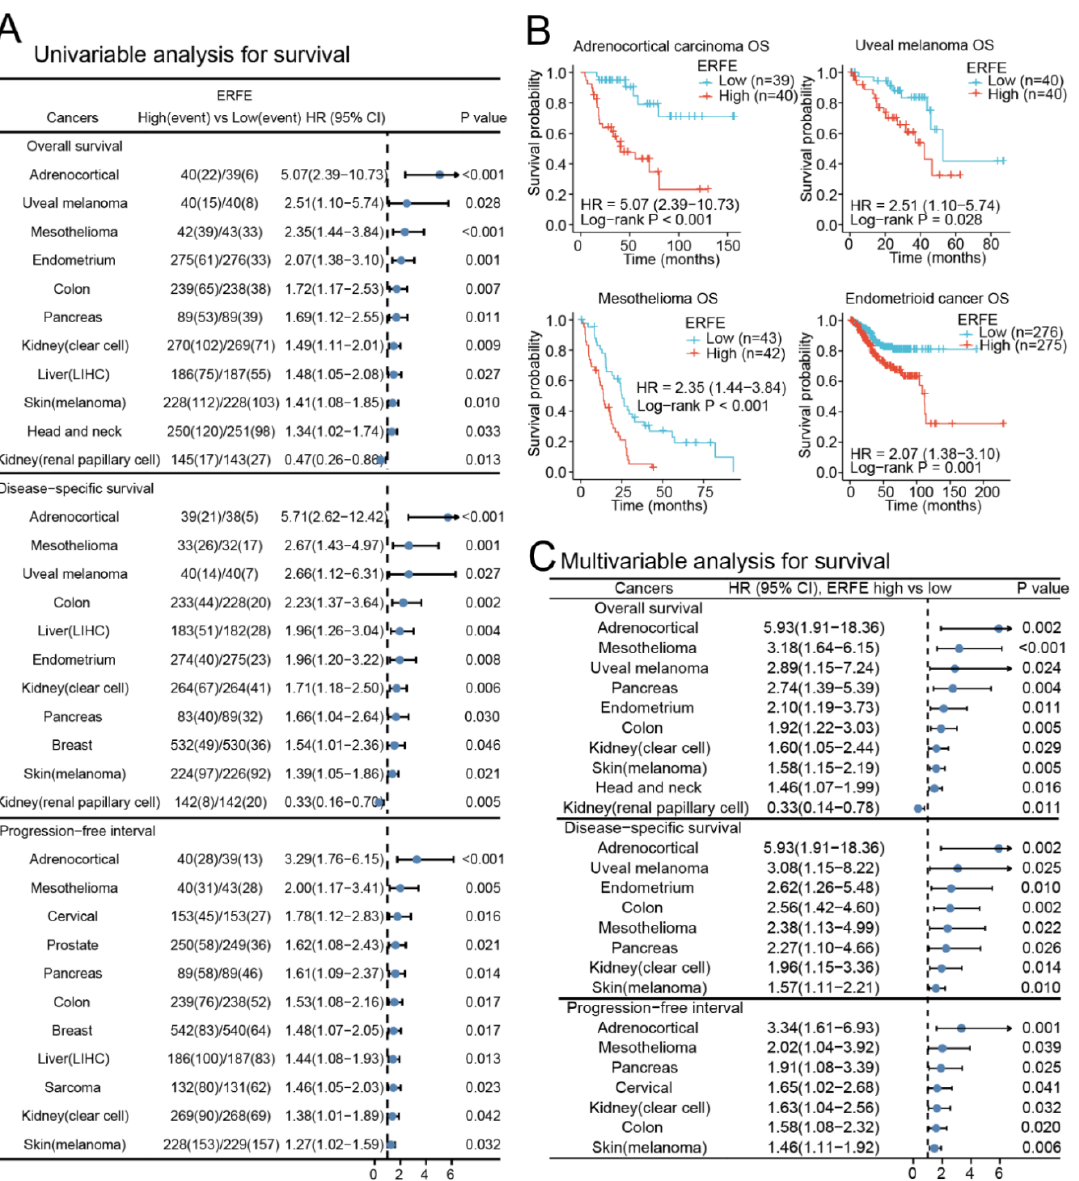
Figure 2. Prognostic significance of ERFE expression in pan-cancer. ( A ) Forest plot of survival (OS, DSS, and PFI) associations with ERFE expression levels in univariable analyses. Log-rank test was conducted in pan-cancer and results with p < 0.05 were summarized. ( B ) Examples of survival analysis are shown. Kaplan – Meier analysis was performed. ( C ) Forest plot of OS, DSS, and PFI associations with ERFE expression levels in multivariable analyses. Cox regression analysis was conducted using TNM and treatments as confounders. Results with p < 0.05 were summarized.